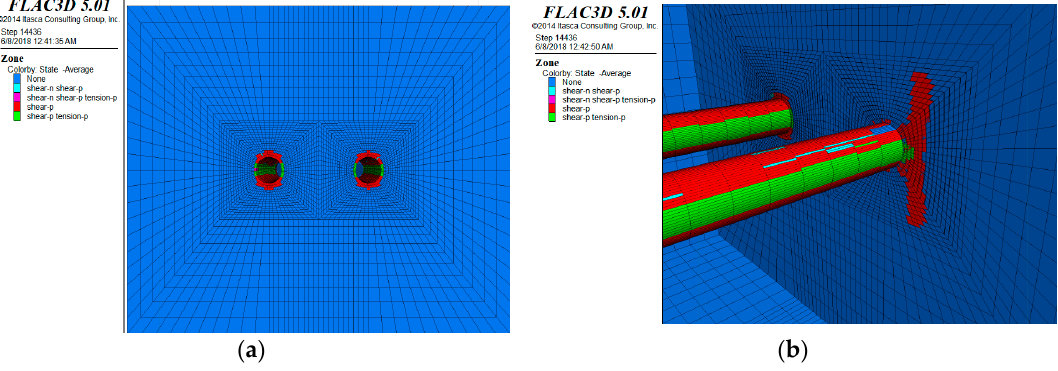
Figure 10. Zone state after excavation stage: ( a ) cross ‐ sectional view and ( b ) longitudinal view.